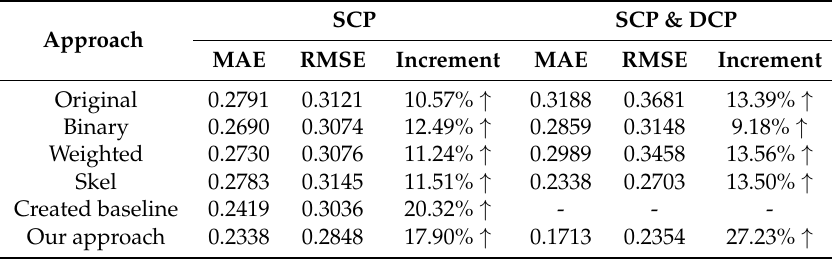
Table 4. Comparison with the state of the art and the created